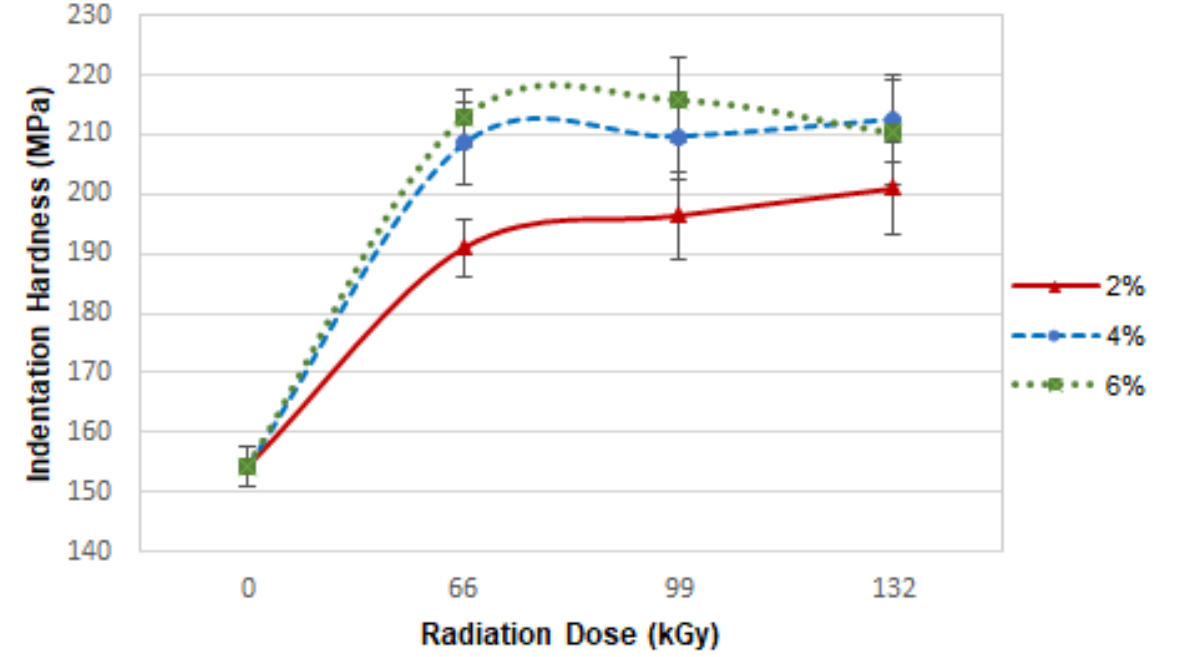
Figure 5. Dependence of indentation hardness on radiation intensity and TAIC concentration.